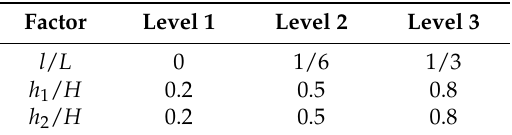
Figure 1. Configuration sketch of the proposed thermal radiation oven. Subgraphs I , II , and III are the oven from stereoscopic perspective view, top view, and front view, respectively. Table 1. Three levels of control factors l / L , h 1 / H , and h 2 / H